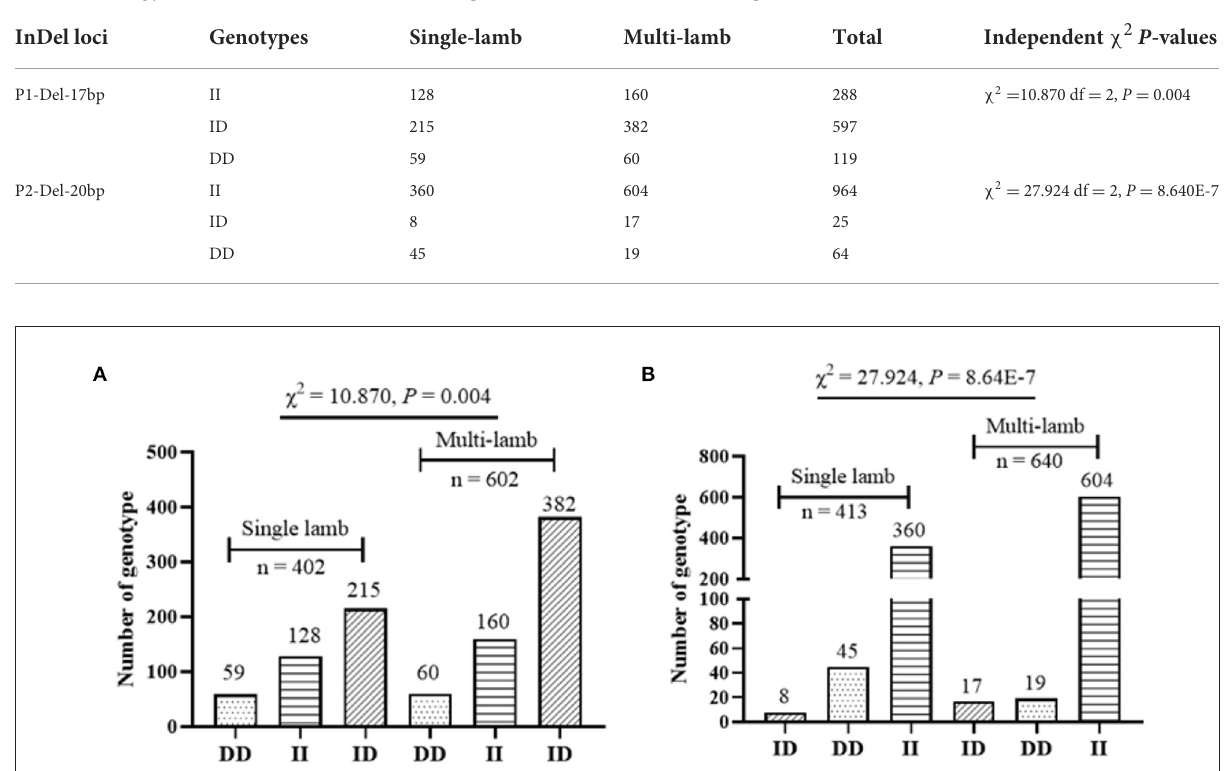
TABLE 4 Genotype distribution between mothers of single-lamb and multi-lamb in SBWC goats.